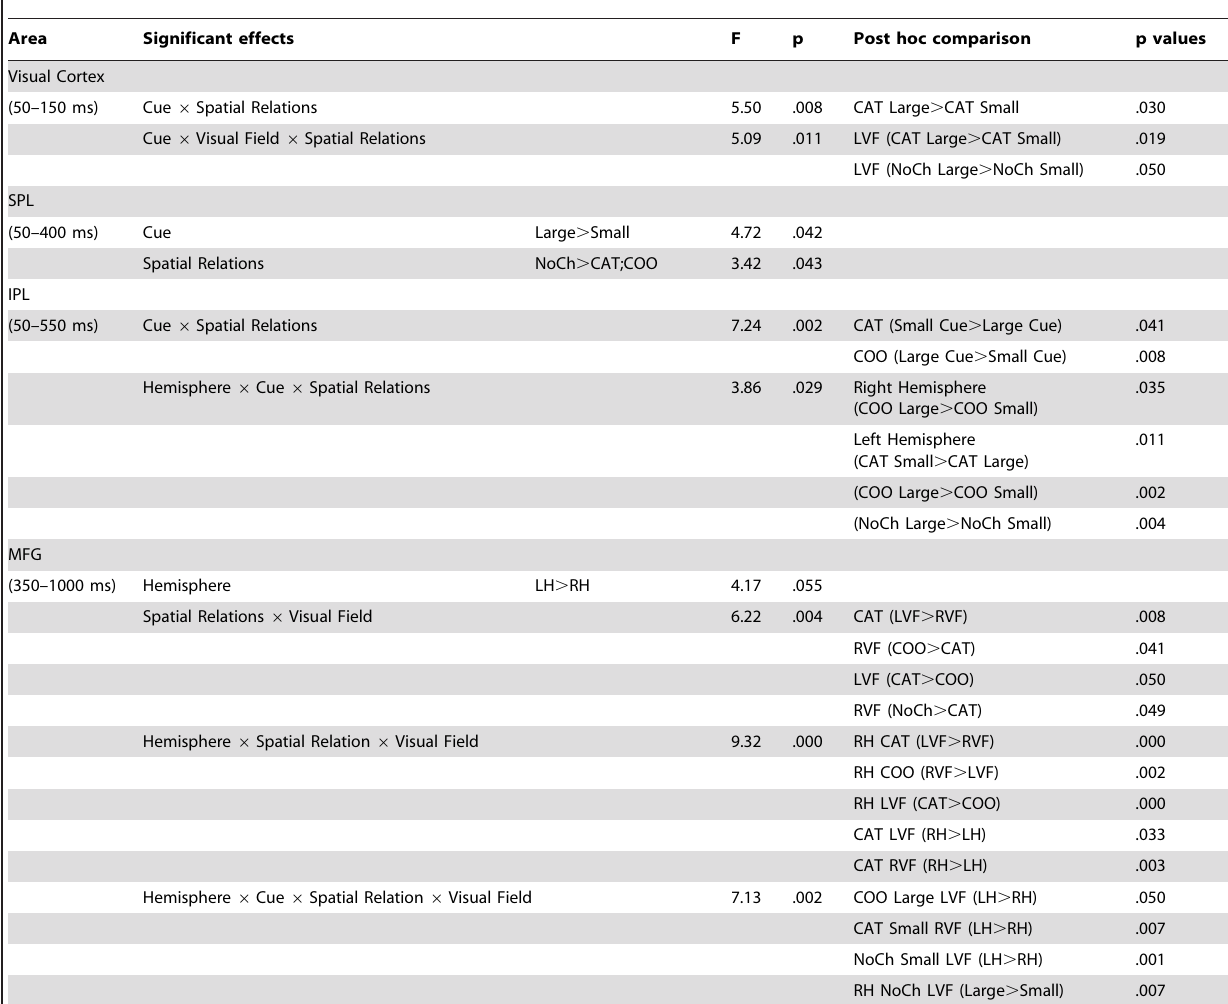
Table 3. Significant statistical